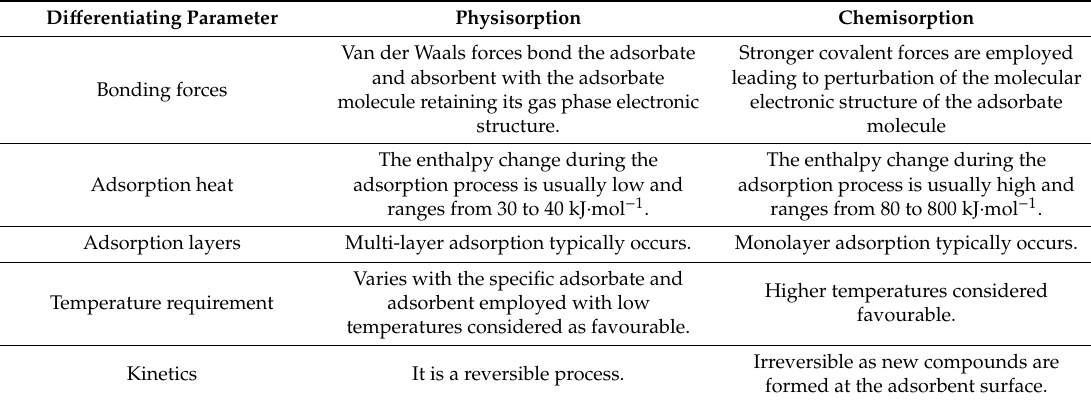
Table 1. Major di ff erences between physisorption and chemisorption